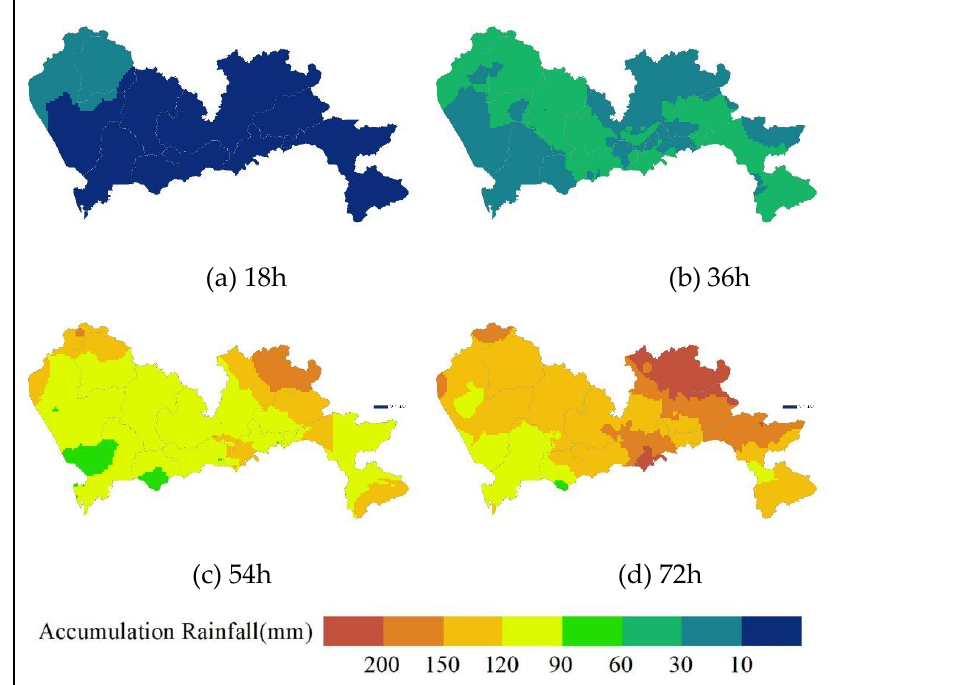
Figure 6. Temporal and spatial distribution pattern of the type I characteristics of 72 h rainfall in Shenzhen.